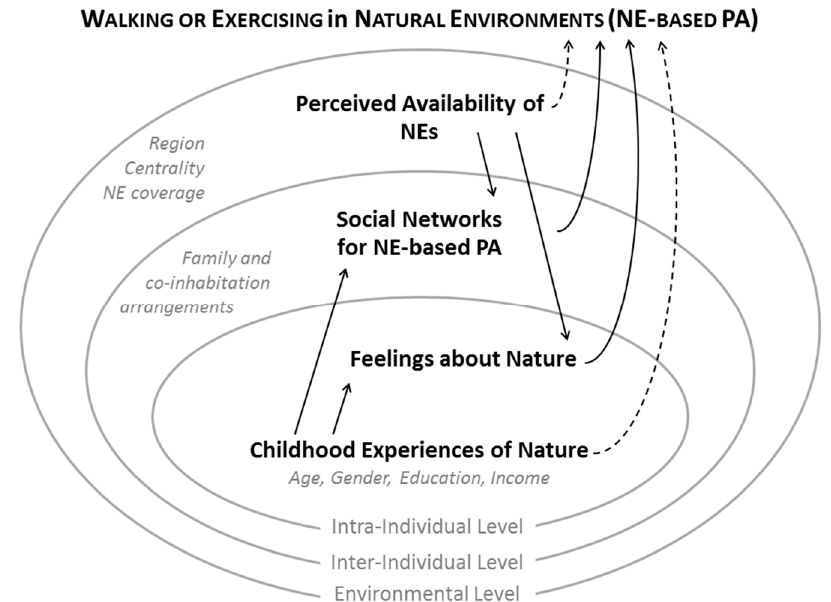
Figure 1. Proposed conceptual model based on an ecological framework that depicts participation in walking or exercising in natural environments (NE-based PA). In bold: predictors and mediators; in italic: control variables. Solid lines: hypothesized direct effects; dotted line: hypothesized indirect effects.